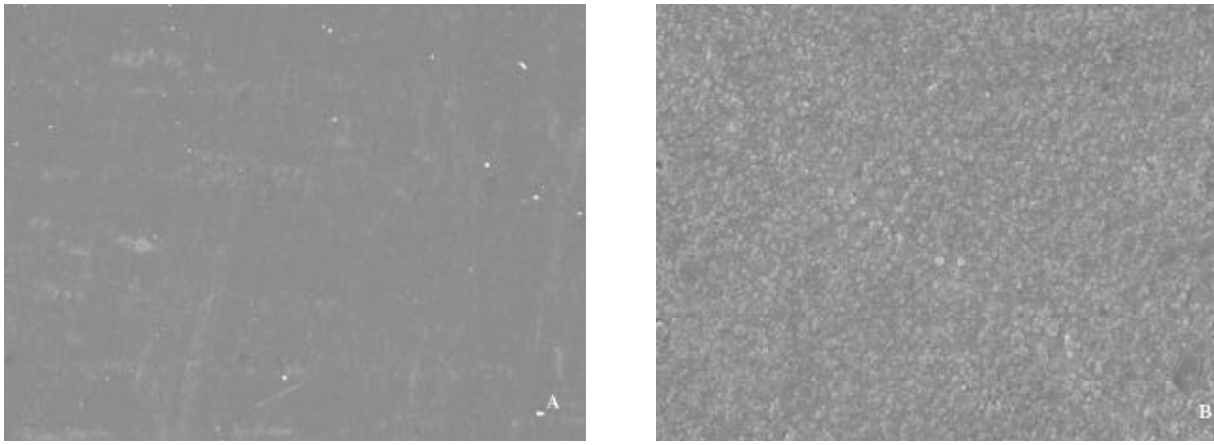
FIGURE 4 - Z250 conventional composite: (A) after polishing with Sof-Lex discs and before mechanical toothbrushing test; (B) after mechanical toothbrushing test. Original magnification 2500x